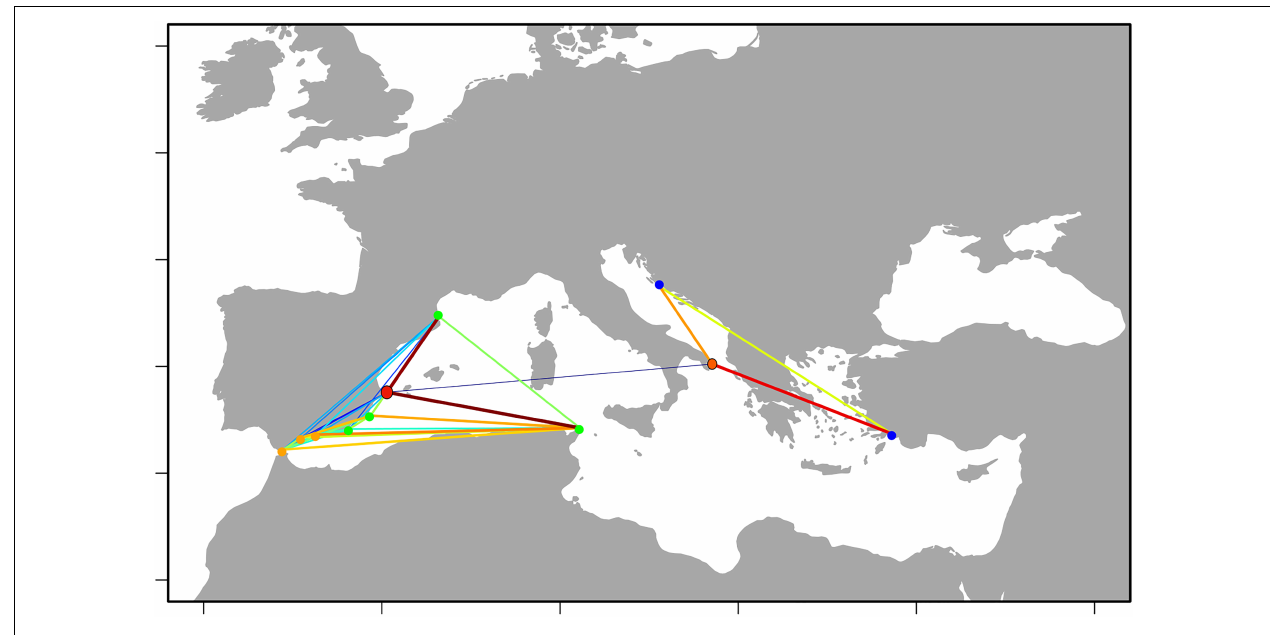
FIGURE 5 | Network of the populations overlapped on the geographic map. The populations marked in red or orange (XA and OT) share the edge linking the two parts of the network just above the percolation limit, and have therefore the highest betweenness centrality. Edge thickness and color reflect the strength of the edges. Colors follow a jet colormap, with cold colors indicating weaker edges and hot colors stronger edges. TABLE 2 | Results of the envfit tests and the partial Mantel tests performed. envfit r 2 p-value Partial Mantel tests Mantel statistic p -value